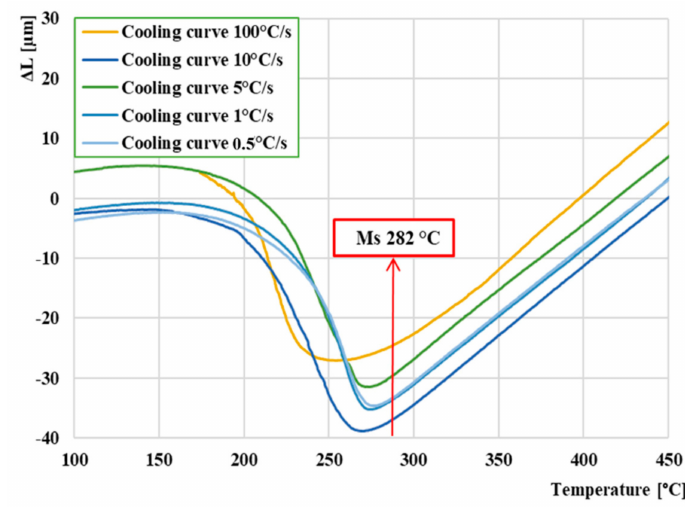
Figure 8. Comparison and determination of average temperature Ms.